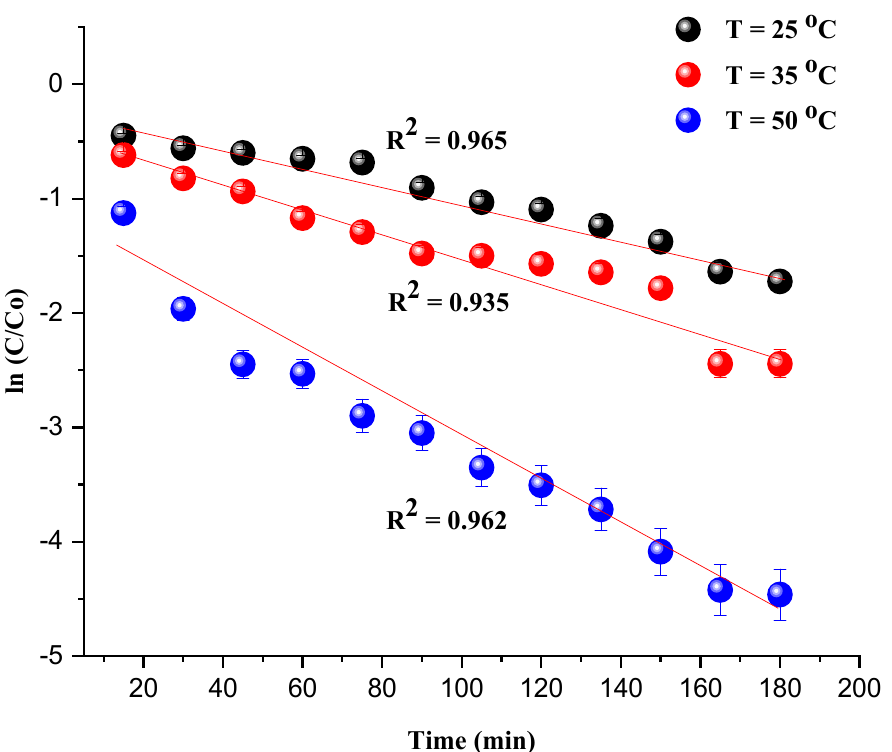
Figure 9. ln( C / C 0 ) as a function of time t (min) (Reaction conditions: C 0 = 20 mg/L, catalyst mass = 0.8 g, and pH = 7).